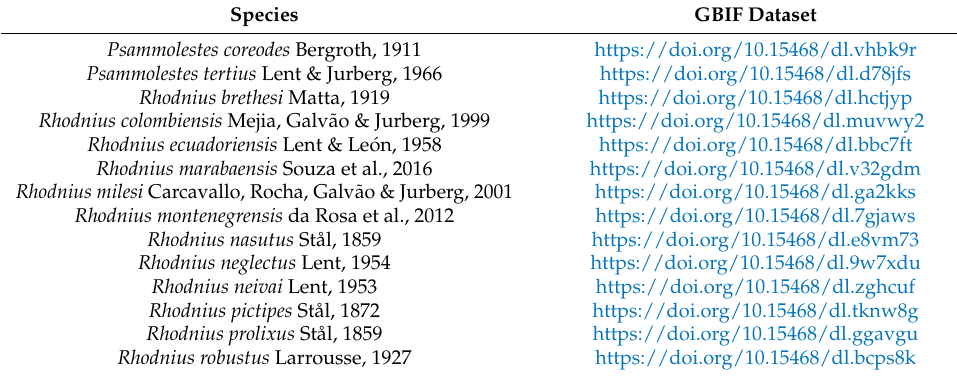
Table 2. List of occurrence datasets for each species obtained from GBIF. Species GBIF